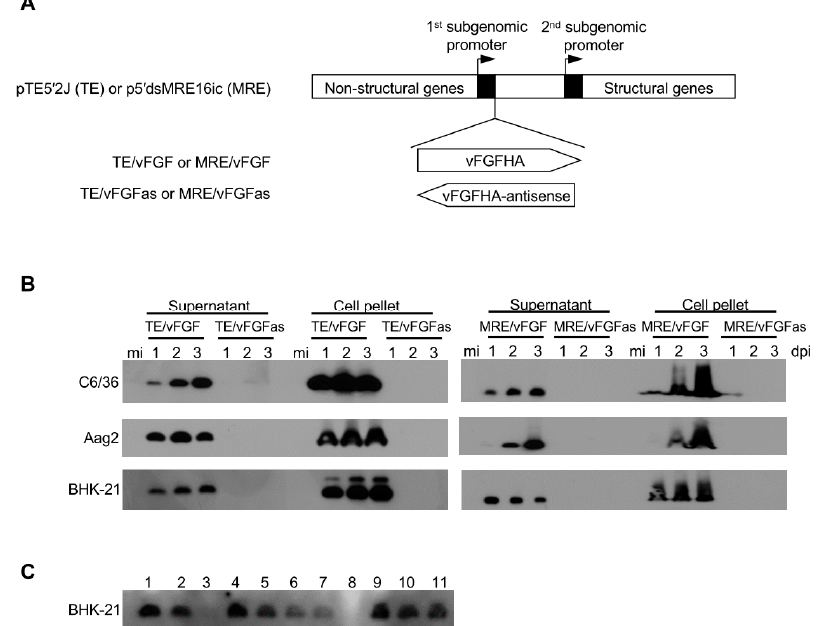
Figure 3. Construction of recombinant SINV and expression of vFGF. ( A ) Schematic of recombinant SINV constructions. vFGF with a C-terminal HA epitope tag was inserted into the infectious clones TE5 (cid:48) 2J or 5 (cid:48) dsMRE16ic in the sense or antisense orientation under the 5 (cid:48) subgenomic promoter to construct the recombinant SINV TE / vFGF, TE / vFGFas, MRE / vFGF and MRE / vFGFas. ( B ) Detection of HA-tagged vFGF expression by immunoblotting. Aag2, C6 / 36 and BHK-21 cells were mock-infected (mi) or infected with recombinant SINV and cells and their supernatants were harvested at 1, 2, or 3 days post-infection (dpi) to obtain lysates. vFGF was detected with anti-HA antibody. ( C ) Detection of vFGF in individual viral plaques. Plaque isolates of TE / vFGF stock virus were tested for vFGF expression by immunoblotting. Eleven plaques were picked and virus amplified in BHK-21 cells. Supernatants were collected and processed for